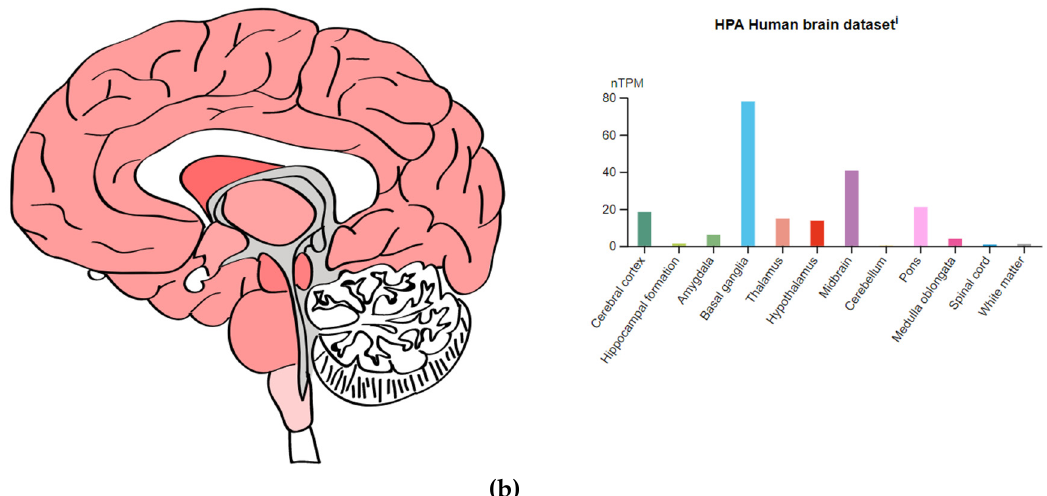
Figure A4. Expression of the DRD2 gene in the human body ( a ) and the brain ( b ) [81].